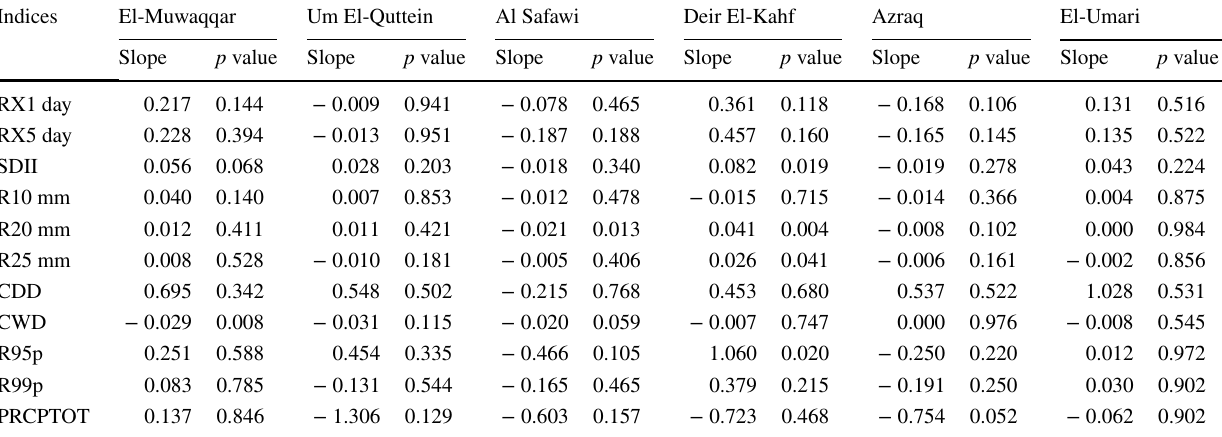
The bold yellow-hatched values represent statistical significance at 5% level ( p <